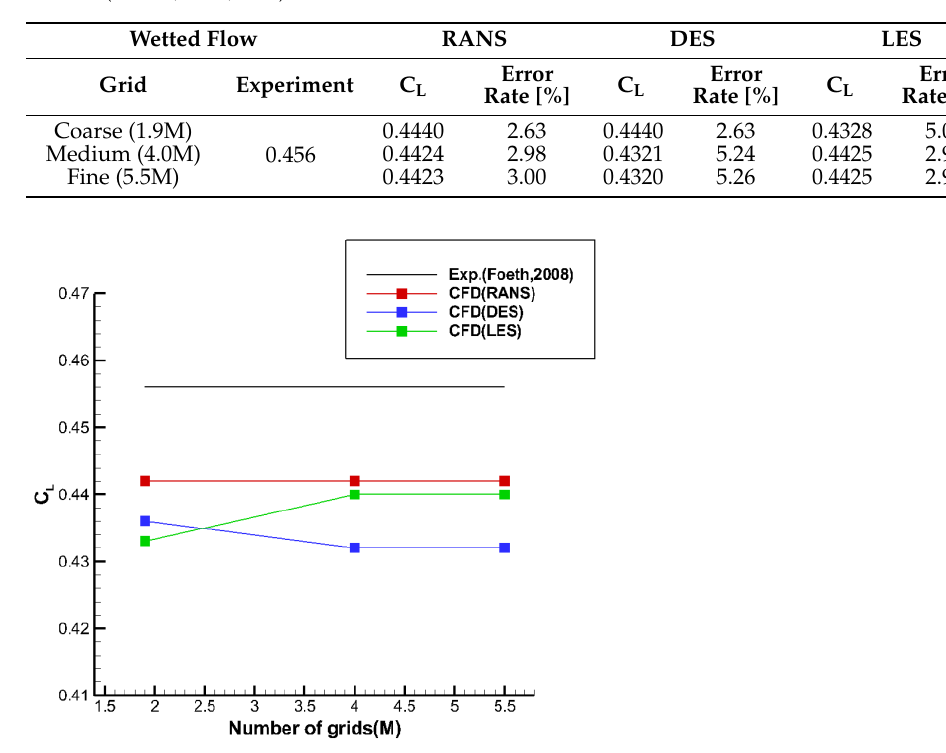
Table 1. Time-averaged lift coefficient in wetted flow according to the number of grids and turbulence models (RANS, DES, LES).